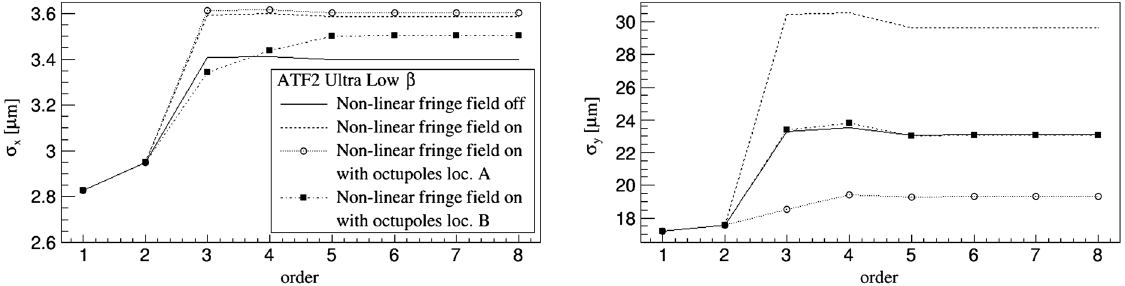
FIG. 12. Nonlinear fringe field impact on the horizontal (left) and vertical (right) beam size in the ATF2 ultra low β (cid:1) lattice.